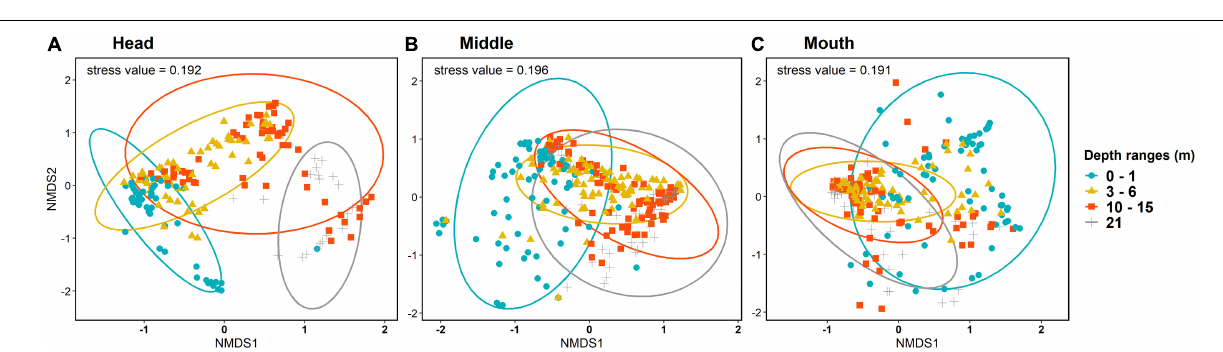
FIGURE 5 | Non-metric Multidimensional Scaling (NMDS) ordination plots of the observational units based on Bray-Curtis dissimilarities between depth ranges at (A) head, (B) middle, and (C) mouth sections of Comau